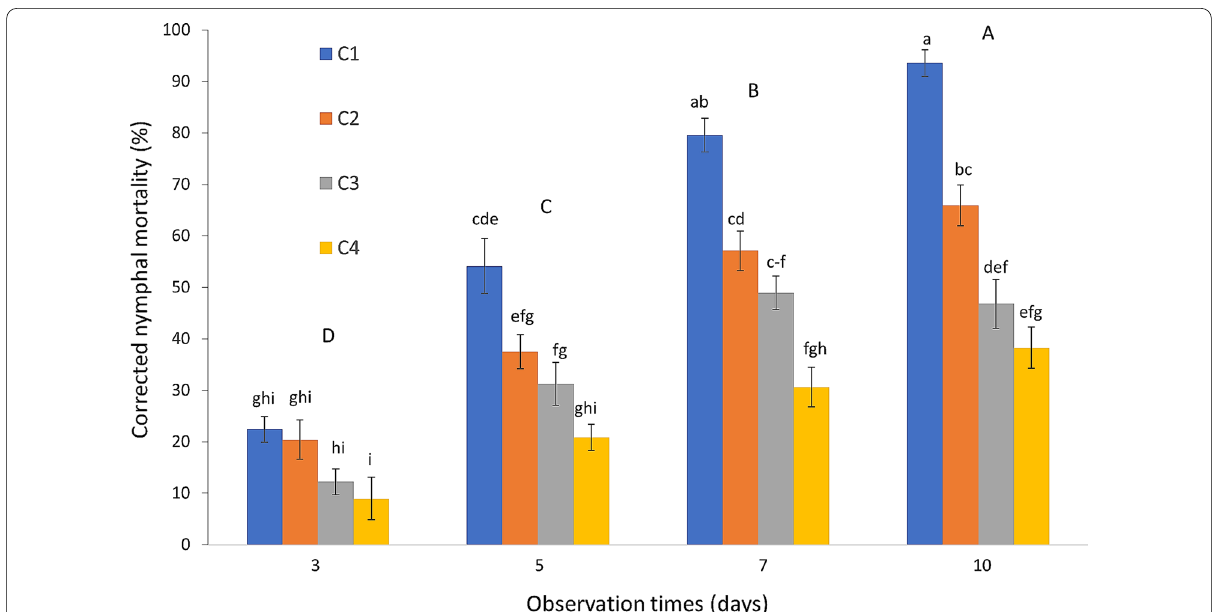
Fig. 1 Percent corrected mortality (mean S.E.) of late 3rd instar nymphs of peach-potato aphid Myzus persicae bioassayed against different ± concentrations of indigenously isolated strain of entomopathogenic fungus Beauveria bassiana under laboratory conditions. Concentrations C1–C4 correspond to 1.0 10 6 –1.0 10 9 conidia/ml. Small letters at bar tops indicate significant difference among the concentrations, while capital letters × × indicate overall significant difference among the mortality at different time intervals (factorial ANOVA followed by Tukey’s HSD test at α